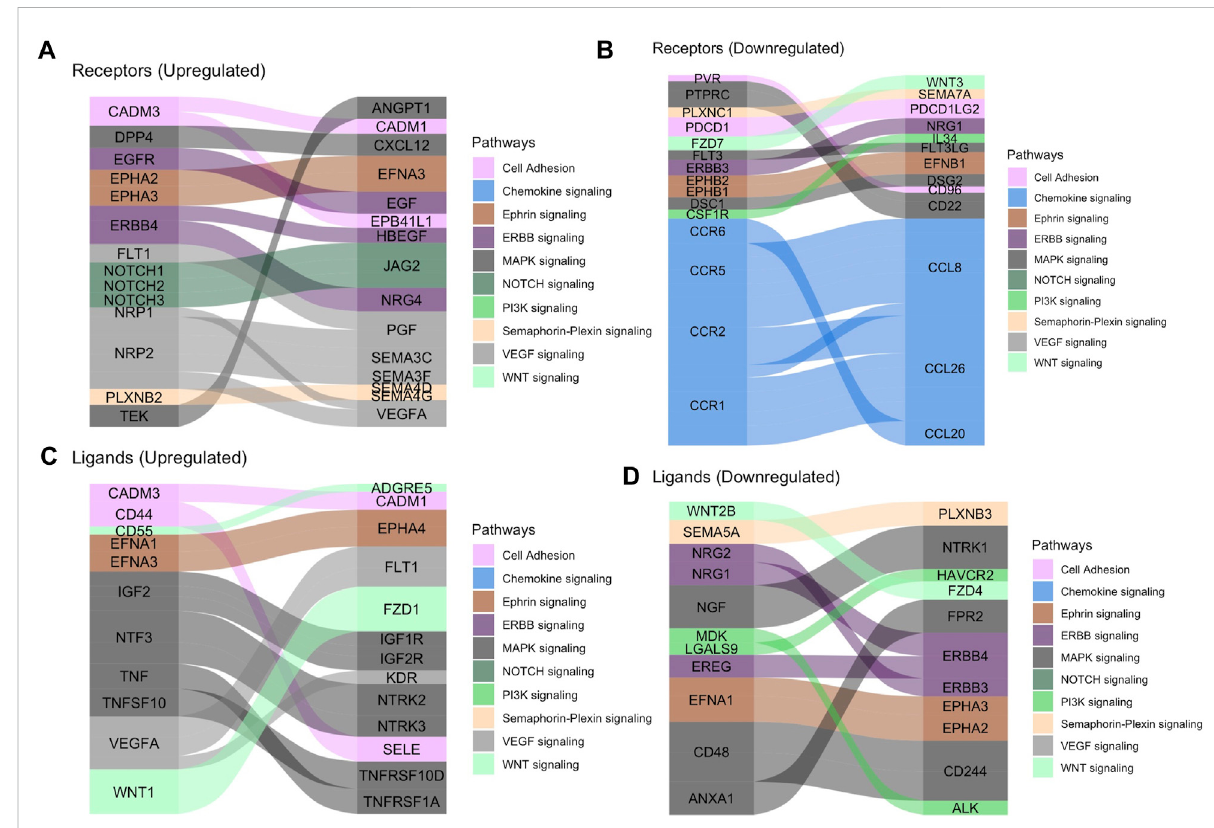
FIGURE 2 Tissue-tissue interactions showing receptor/ligand pairs in the central retina. (A) Upregulated macular receptors in the RPE/choroid are linked to their upregulated ligand in the macular neural retina. Interactors are grouped by signaling pathway and the width is scaled by averagelog2fold change. (B) Downregulatedmacular receptorsintheRPE/choroidandtheir respectivedownregulatedligandinthemacular neural retina. (C) Upregulated macular ligands in the RPE/choroid are linked to their upregulated receptor in the macular neural retina. (D) Downregulated macular ligands in the RPE/choroid and their corresponding downregulated receptors in the macular neural